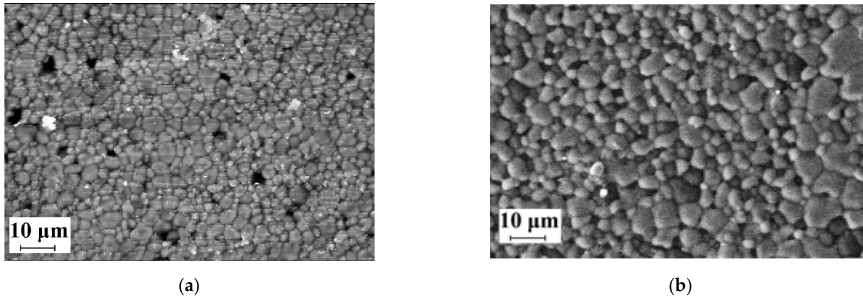
Figure 7. Microstructure of sample sintered of aerosol powders of yttrium-aluminum garnet (scanning electron microscopy): ( a ) at 1500 °C for 3 h; ( b ) at 1700 °C for 6 h. The observed structure is characterized by a uniform distribution of equiaxed grains with a small size scatter. However, in samples sintered at a temperature of 1500 °C for 3 h, the presence of residual pores is still observed. On samples sintered at 1700 °C for 6 h, a higher-quality structure was obtained that does not contain visible pores. In this work, the density of the obtained samples was measured by hydrostatic weighing. Recalculation of the real density in % was carried out, taking the density of the crystal YAG-ρ t = 4.55g/cm3 as the basis of reference. The density of the ceramic material measured on a sample sintered at a temperature of 1500 °C for 3 h was 97.3% of the density of the YAG crystal. The density of polycrystalline ceramics sintered at a temperature of 1700 °C for 6 h was 99.2% of the base value. X-ray phase analysis of sintered samples revealed a curious fact. The phase composition of the sintered samples is identical to the phase composition of aerosol powders made of the working solution with the addition of urea, fired at 1000 °C for 3 h (Figure 8). In other words, the transformation of the material into the Y 3 Al 5 O 12 phase is fully completed during the sintering of aerosol powders in the sample. At the same time, the presence of microcracks that could arise due to volumetric changes, as mentioned above, could not be detected in the sample.